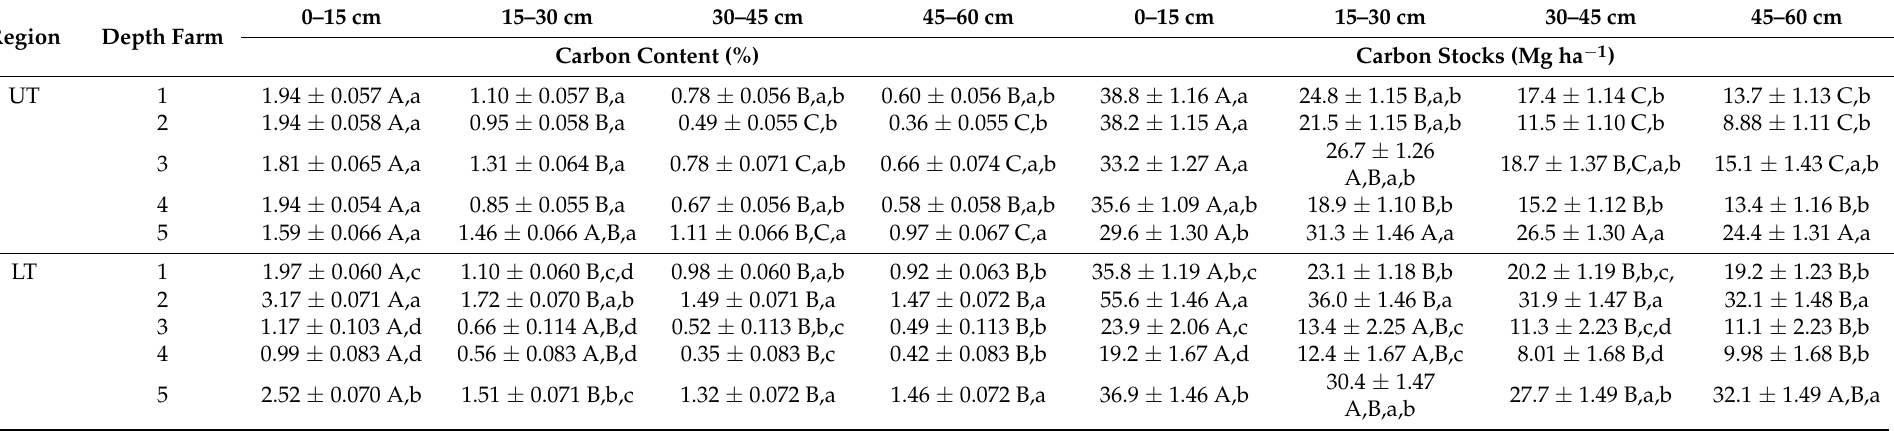
Table 6. Response of soil C contents and stocks (mean ± standard error) to the interactive effects of farm and depth under mixed pastures in the Upper (UT) and Lower (LT) Tsitsikamma dairy